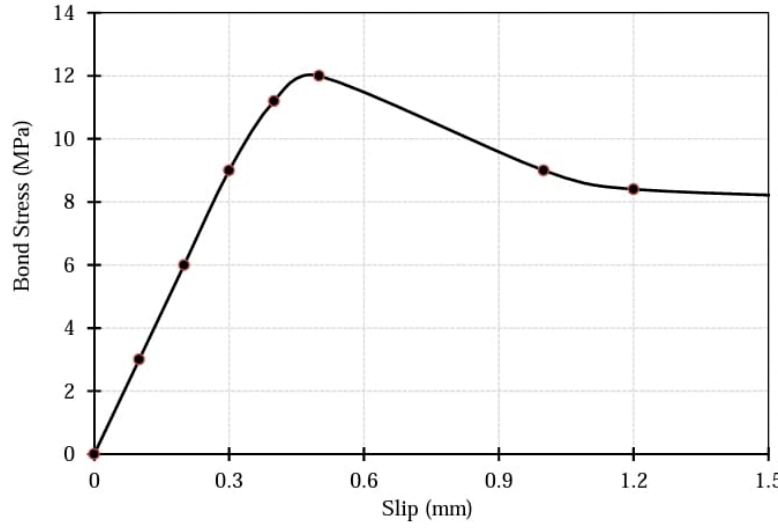
Figure 2. Bond Stress ‐ Slip Model for sand ‐ coated GFRP bars